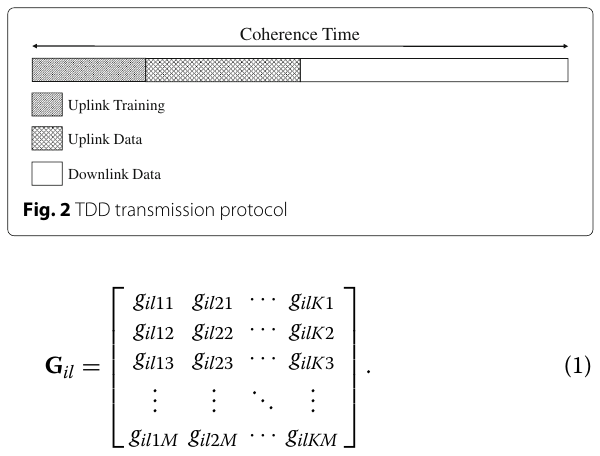
Figueiredo etal. EURASIPJournalonWirelessCommunicationsandNetworking (2018) 2018:14